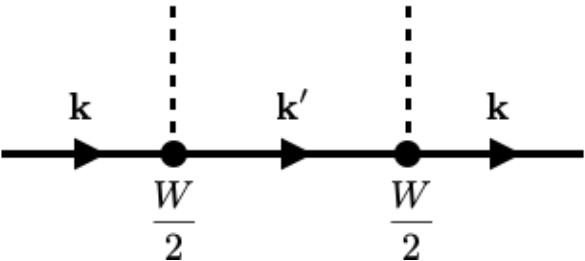
Figure 10: The Feynman diagram to calculate the second order self-energy [ Eq. (C.3) ] . The solid lines are the bare Fermion propergators, and the dashed lines are the quasiperiodic